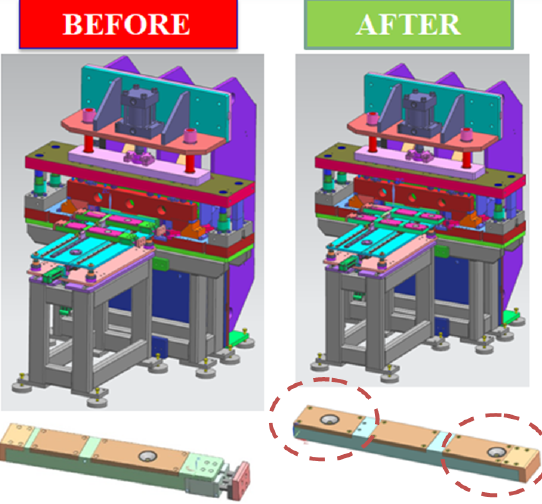
Figure 20. Optimization of the centering process.